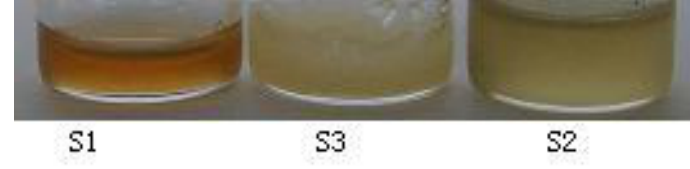
Figure 1. Color and state of the essential oils of three tested samples at room